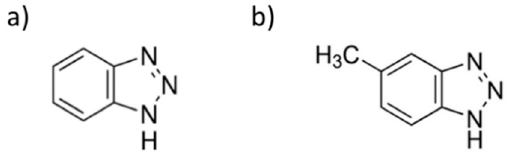
Figure 1. Chemical structure of ( a ) 1H-benzotriazole (BZT) and ( b ) 5-methyl-1H-benzotriazole (Me-